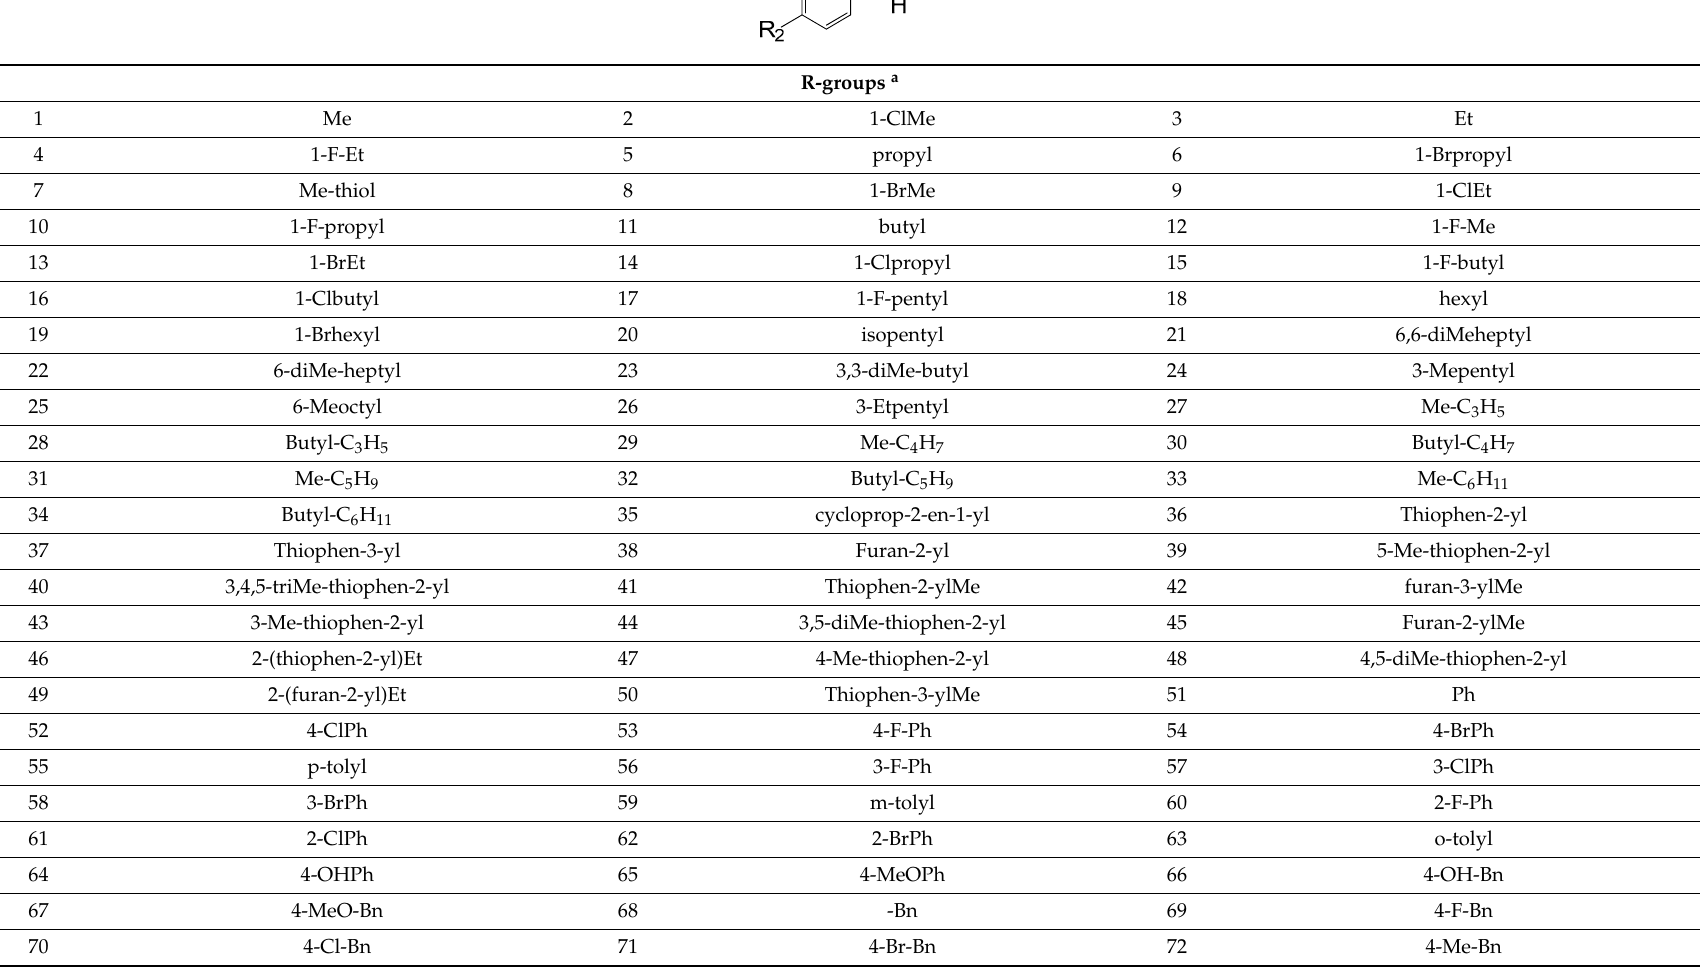
Table 5. R 1 - and R 2 -groups (fragments, building blocks, substituents) used in the design of the initial diversity virtual combinatorial library of benzamides.